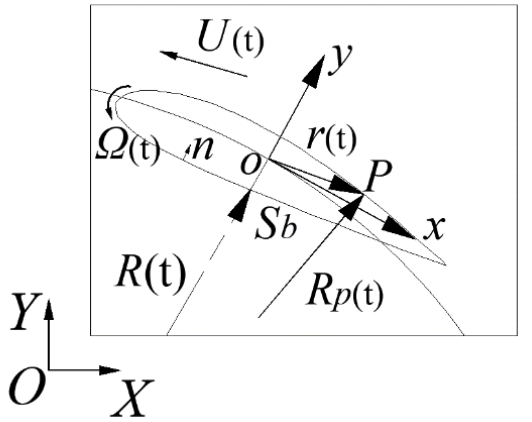
Figure 2. Local coordinate system.